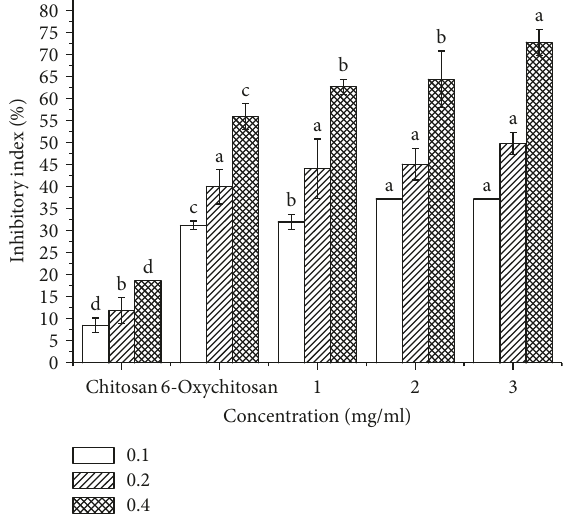
Figure 4: The antifungal activity of chitosan, 6-oxychitosan, 1, 2, and 3 against P.